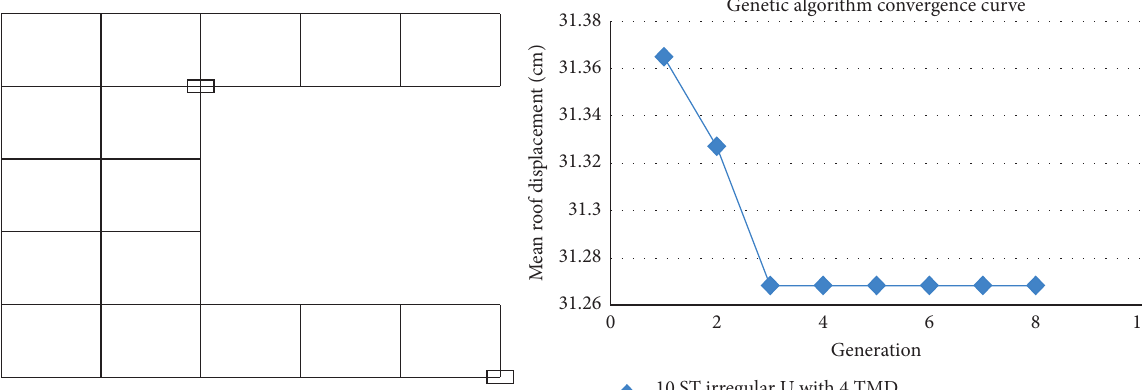
Figure 22: Convergence diagram of the ten-story U-shaped model with 4 dampers in genetic algorithm (right) and damper optimal positions (left).